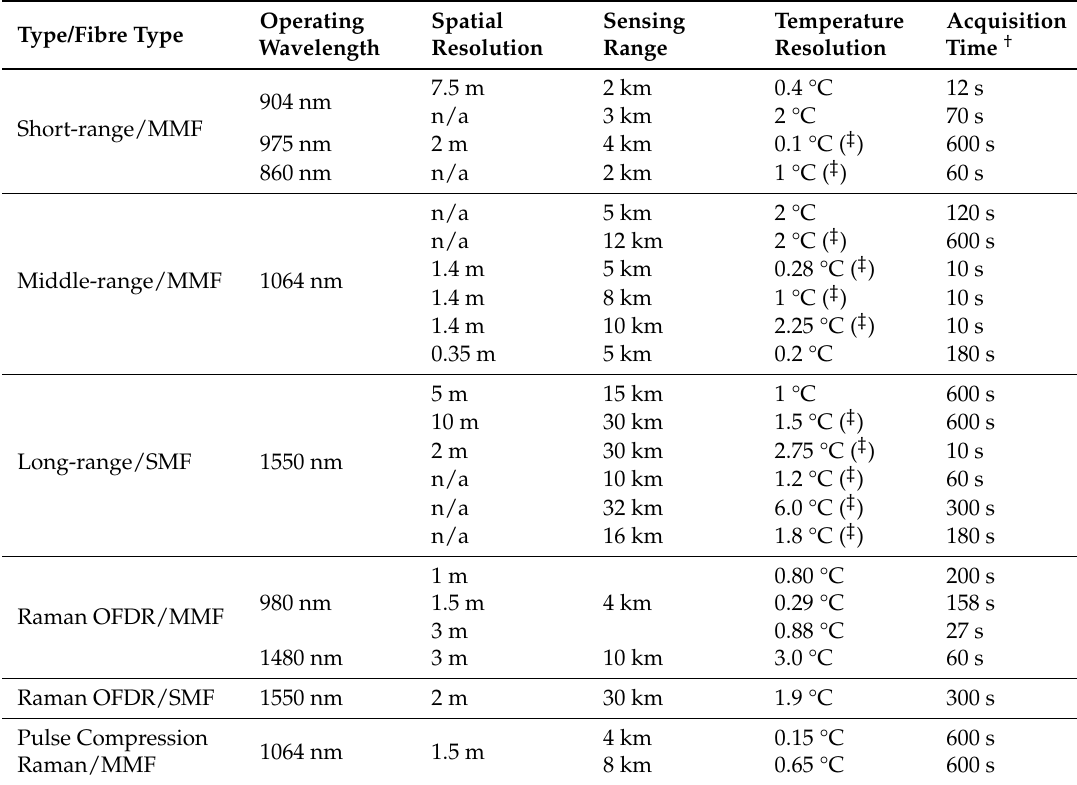
Table 2. Performances of some commercial DTS (sources: producers’ datasheets, technical notes, and scientific